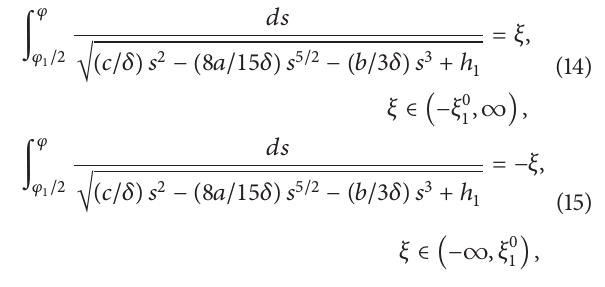
Figure 6: (Corresponding to Example 4). The simulation of integral curve of (6) when 𝑎 = 1 , 𝑏 = −157/3000 , 𝑐 = 1 , and 𝛿 = 1 . (a 1 ) Initial conditions 𝜑(0) = 26.49502557 and 𝜑 󸀠 (0) = 10.49025102 . (a 2 ) Initial conditions 𝜑(0) = 26.49502557 and 𝜑 󸀠 (0) = −10.49025102